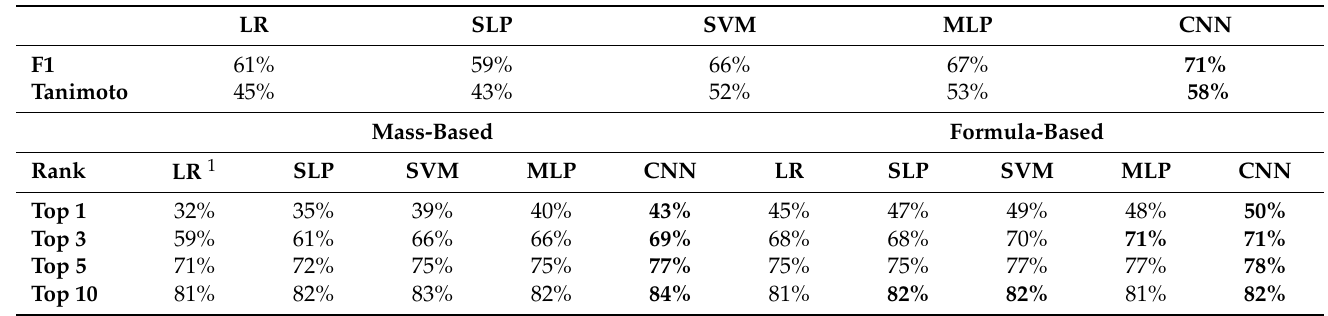
Table 1. Comparison of CNN with other machine learning models based on F1 score, Tanimoto similarity score, and the top- k ranking of the candidates selected by mass-based and formula-based search against compound databases for 29,588 training and 6290 testing compounds. The result of the best performing model under each category is shown in